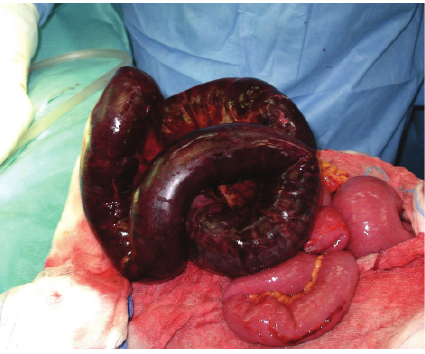
Figure 1: The jejunum is dark and edematous, indicating